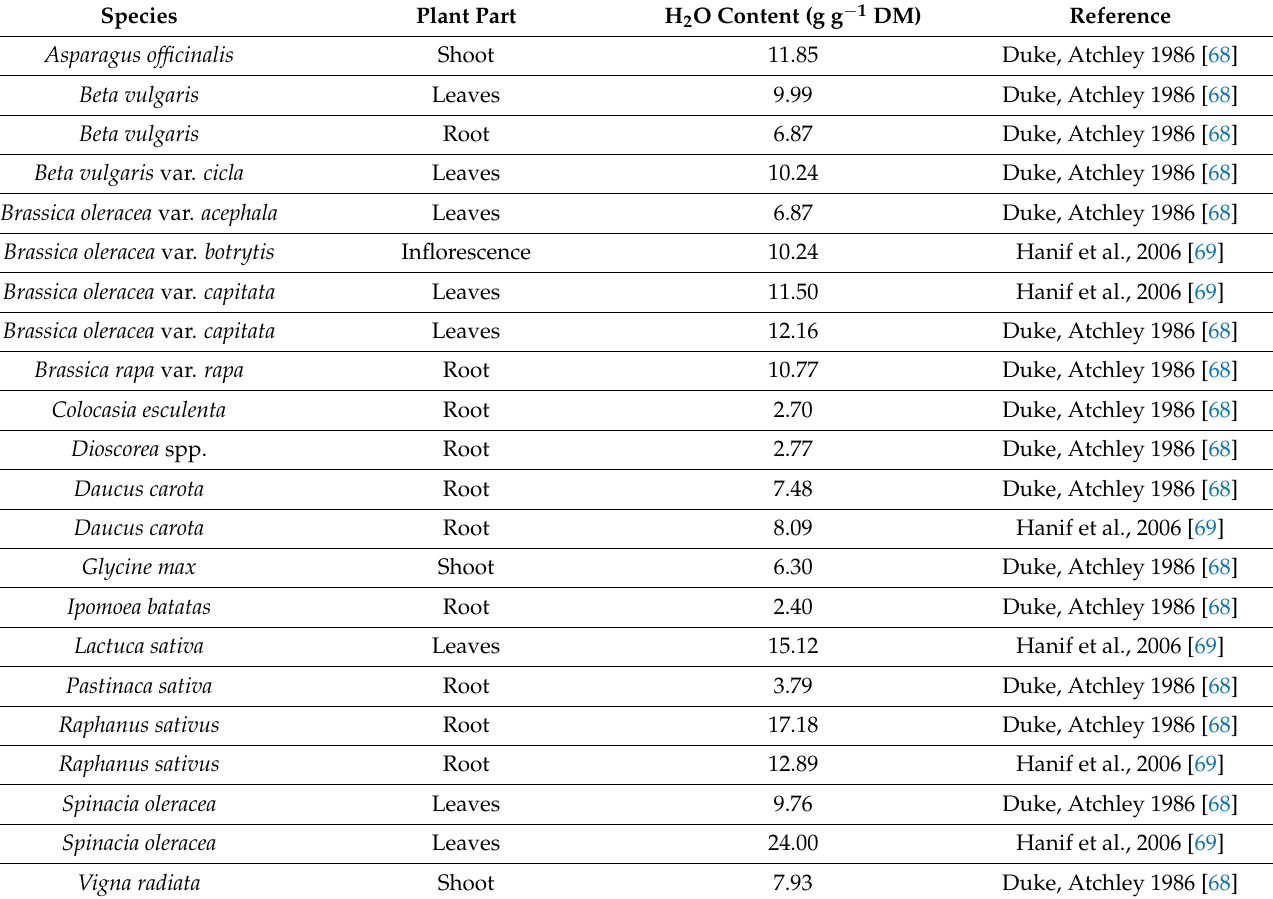
Table 3. Examples of differences in tissue water content values of various